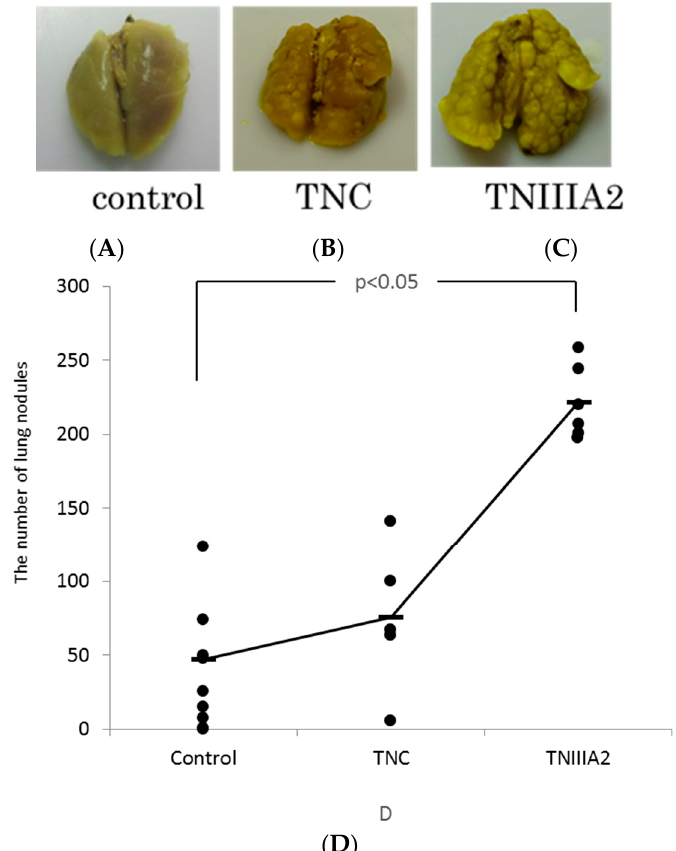
Figure 5. TNIIIA2 increases the number of lung metastatic nodules. A Colon26-M3.1 cell suspension (5.0 × 10 4 cells/100 μ L/head) was injected intravenously into six-week-old Balb/c female mice with or without TNC (5 μ g/head) or TNIIIA2 (5 μ g/head, n = 5 each). Fourteen days after injection, the lungs were stained with Bouin’s fixative. ( A ) The overview of the lungs of mice injected with Colon26-M3.1 alone, ( B ) those with TNC, and ( C ) those with TNIIIA2. The number of lung metastatic nodules was counted ( D ).